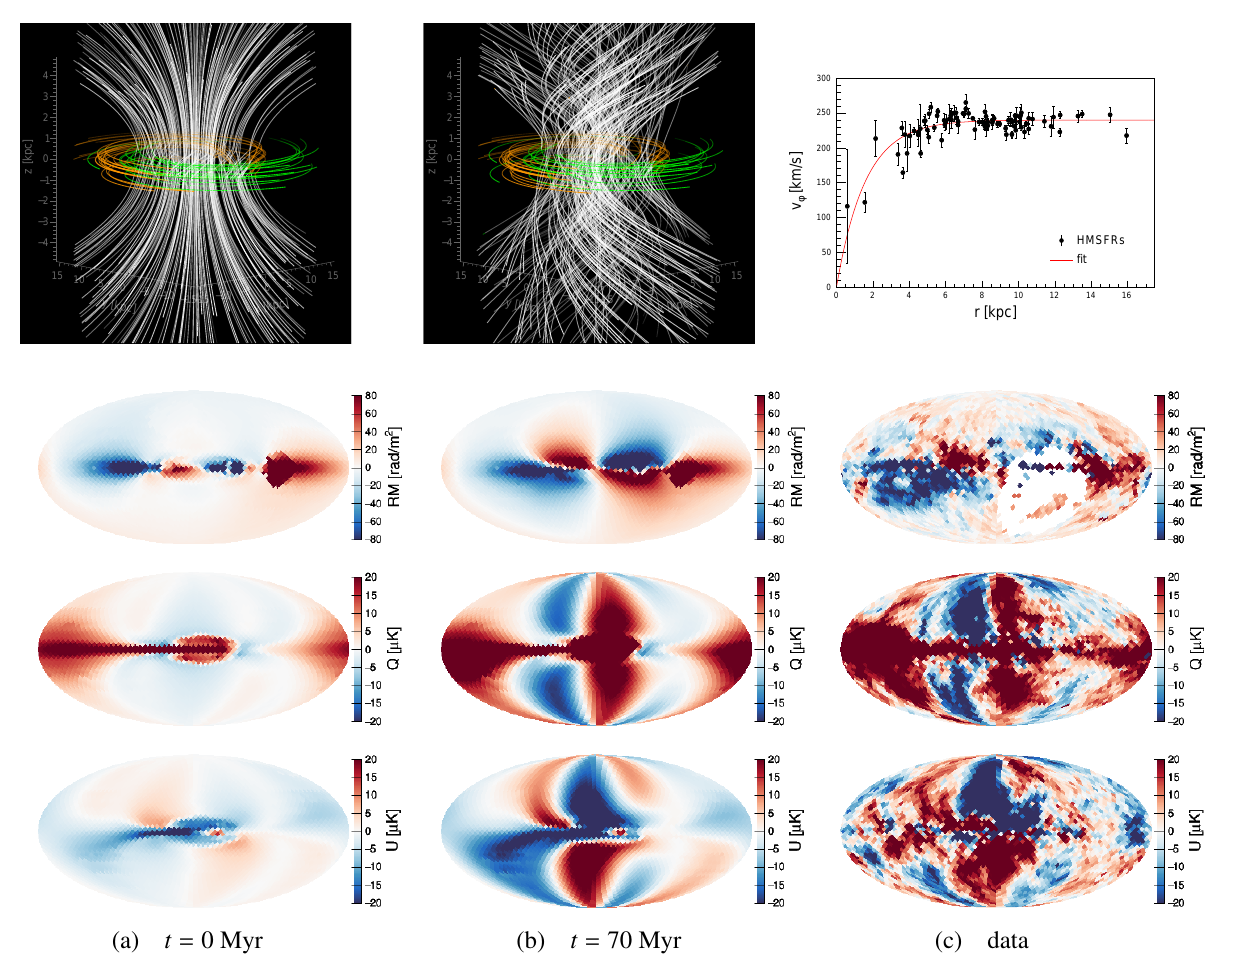
Figure 3. Illustration of the GMF model with a twisted poloidal field. The best-fit model at t = 70 Myr is presented in the middle column and the corresponding un-twisted model at t = 0 is shown in the left column. The lower three rows show the simulated sky maps for RM, Q and U. A visualization of field lines of the models is in the top row. The lines are colored if the toroidal field strength is ≥ 99% of the total field strength. Regions with r · B > 0 are shown in orange, otherwise green is used. The observed sky maps are displayed in the lower three panels of the right-most column (Q and U data from [15], RM data compilation from [4] (see references therein)).. he rotation curve of the Galaxy used for the twisting is shown as a red line in the top-right panel together with measured velocities of high-mass starforming regions (HMSFRs) from